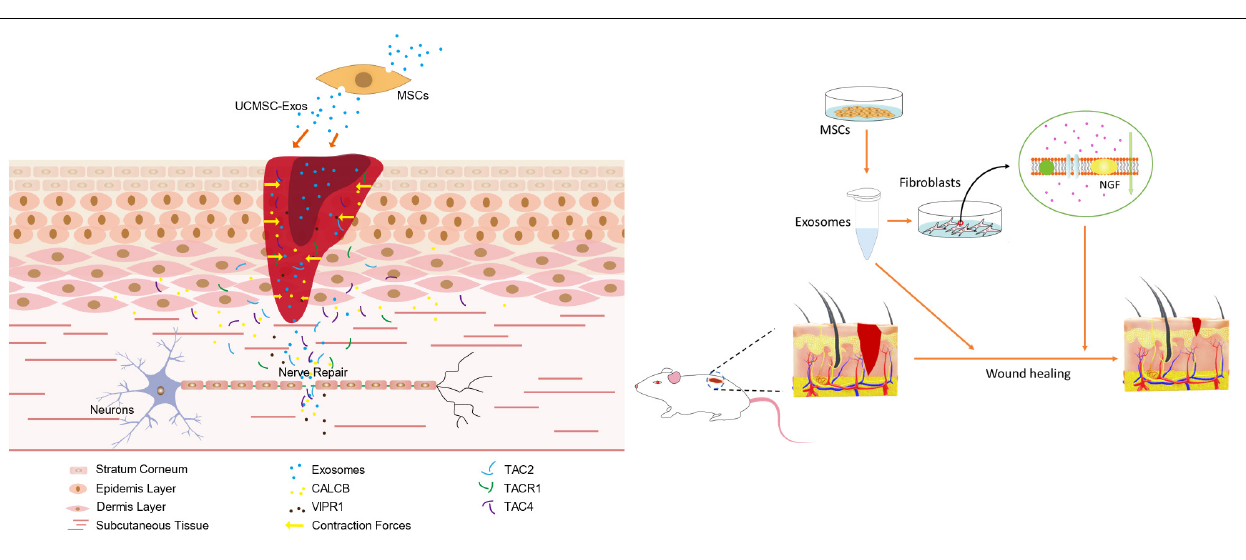
FIGURE 7 | Schematic representation of UC-MSC-Exo promoting wound healing and nerve